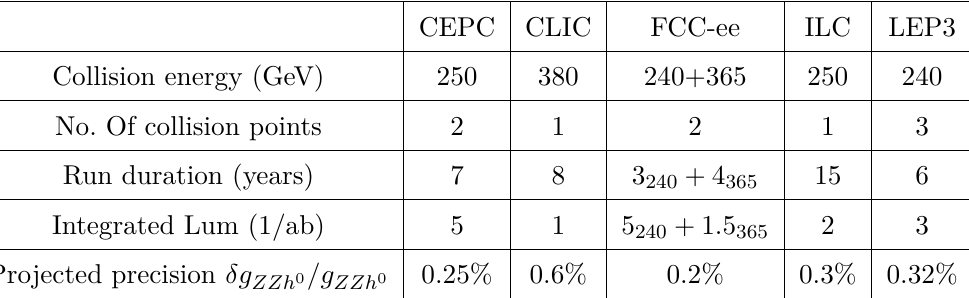
Table 1 . The projected precisions of δg